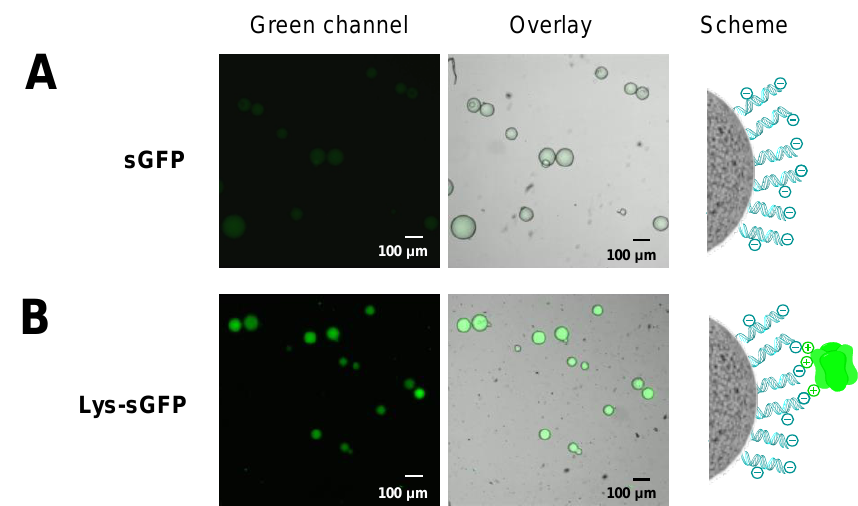
Figure 6. CLSM imaging of Lys-sGFP immobilized on gDNA-coated sepharose microbeads. ( A ) Untagged sGFP was incubated with agarose microbeads functionalized with DNA. ( B ) Lys-sGFP immobilized on agarose microbeads functionalized with DNA through ionic interactions. From left to right: green channel ( λ ex : 488 nm, λ em : LP505 nm), overlay of fluorescence and brightfield signals, and the scheme of the protein immobilization.